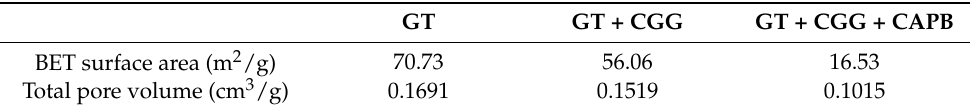
Table 3. The BET analysis of pure and the modified